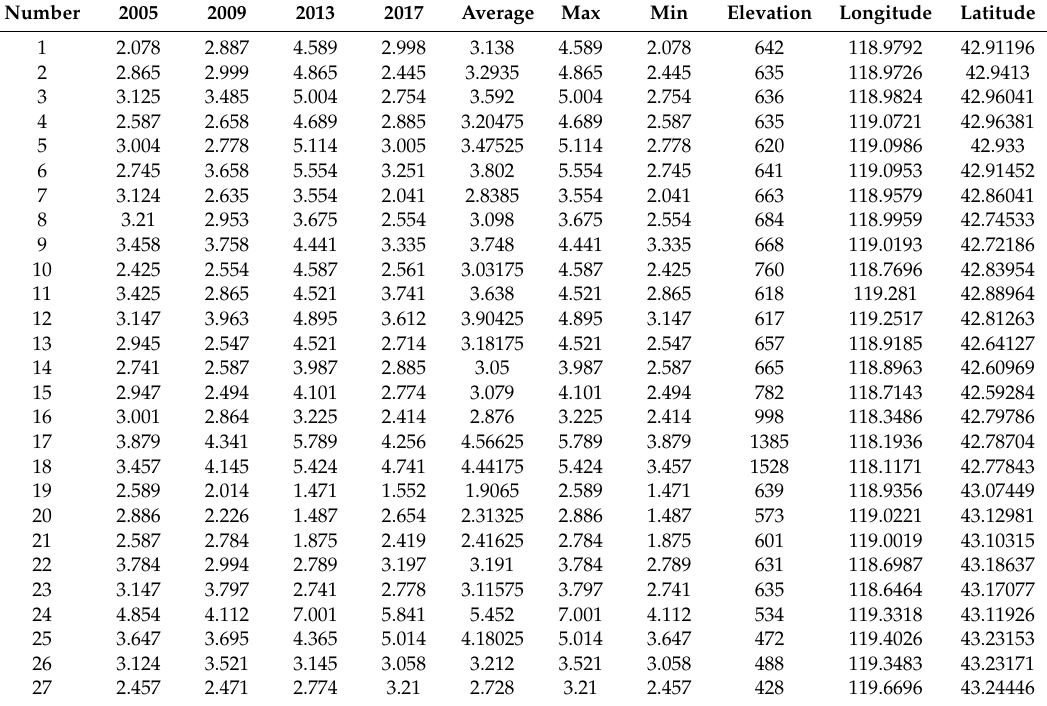
Table A1. Groundwater depth monitoring well